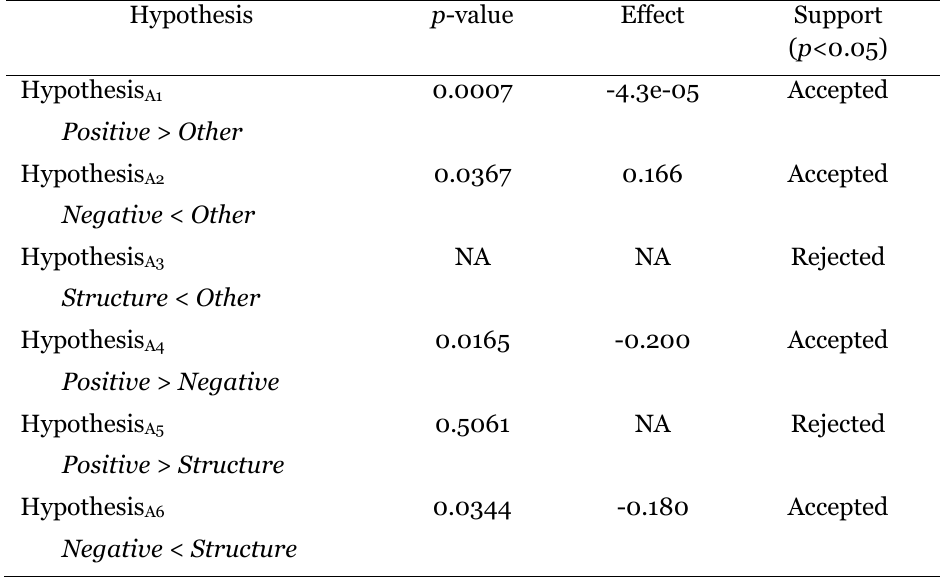
Statistical Tests (Wilcox Pratt) of